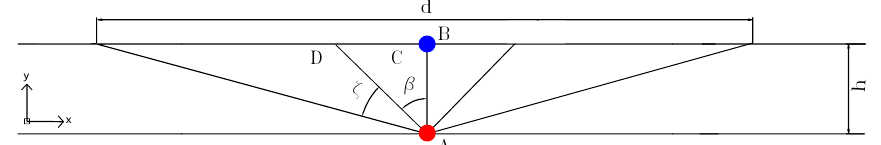
Figure A2. Geometric representation of the judge’s field of view. (A) Judge location; (B) Athlete location; (C) Area of observation for a field of view at β ; (D) Additional Area for field of view allowed through acceptable eye rotation ( ζ ). The x -axis represents the athlete’s direction of progression; the y -axis is orthogonal to the athlete’s direction of progression.